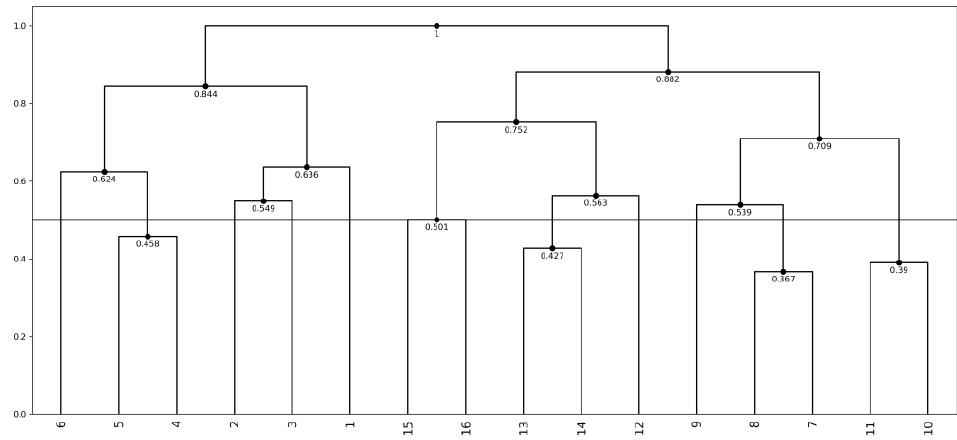
Figure 8. Dendrogram using the HCC for five features.